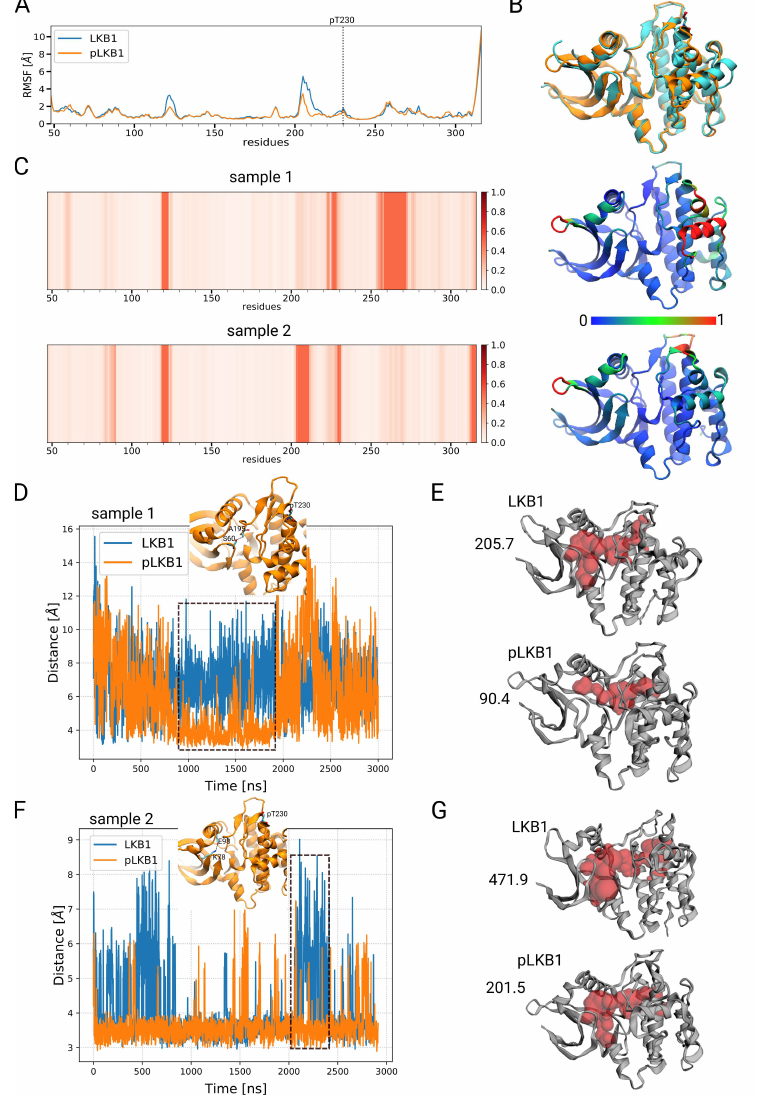
Figure 3. Simulation of LKB1 phosphorylation reveals changes in the ATP-binding pocket. ( A ) The RMSF of the protein C α atoms averaged over the two samples is shown for human LKB1 (Blue)